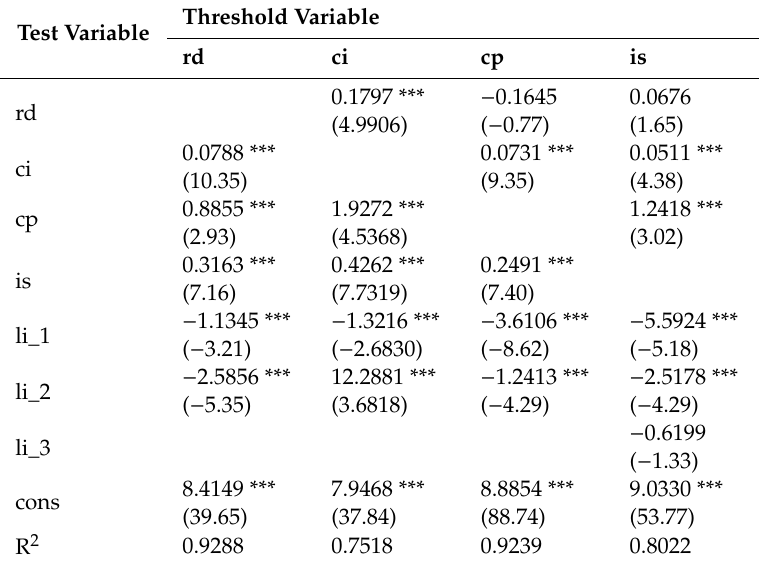
Table 5. Threshold model regression results of loan size and carbon